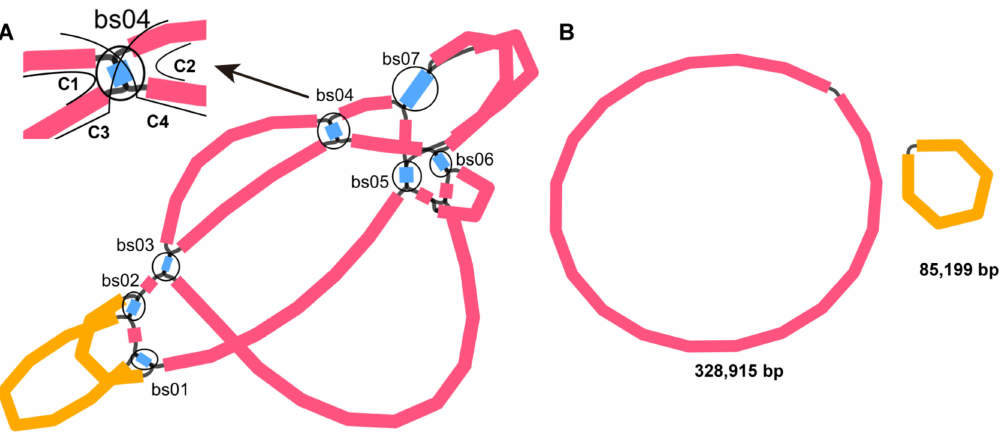
Figure 1. Schematic of the assembly steps of the S. miltiorrhiza mitogenome. ( A ) Unitig graph of the S. miltiorrhiza mitogenome was obtained from de novo assembly of Illumina reads with Unicycler. The unitig graph contained seven contigs (blue) that formed DBSs (bs01–07, black circle). Each DBS has four conformations (C1, C2, C3, and C4), as shown in the top left corner with bs04, as an example. ( B ) Schematic graph of MC1 (pink circle) and MC2 (orange circle) of S. miltiorrhiza after the DBSs were resolved by long reads. The contigs shown in pink and yellow correspond to chromosomes 1 and 2,